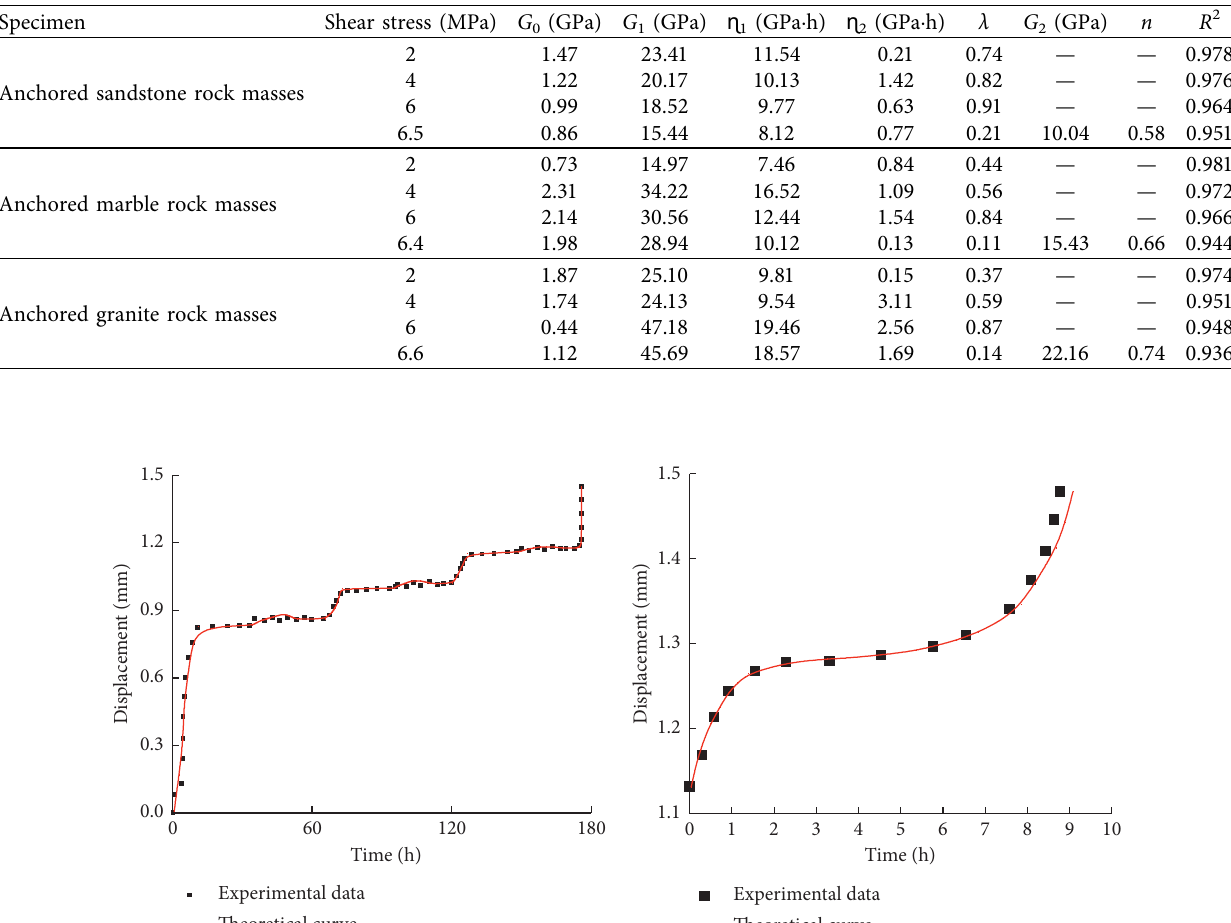
Table 5: Summary of model